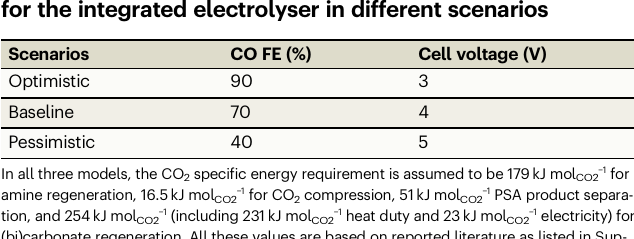
Fig. 3 | Energy comparison between sequential and integrated routes in dif- ferent scenarios. Scenario analysis of ( a ) overall energy consumption, ( b ) thermal energy and electricity consumption, and ( c ) energy cost for sequential and inte- gratedroutes.Inthesequentialroute,theCO 2 electrolyserincludesstate-of-the-art